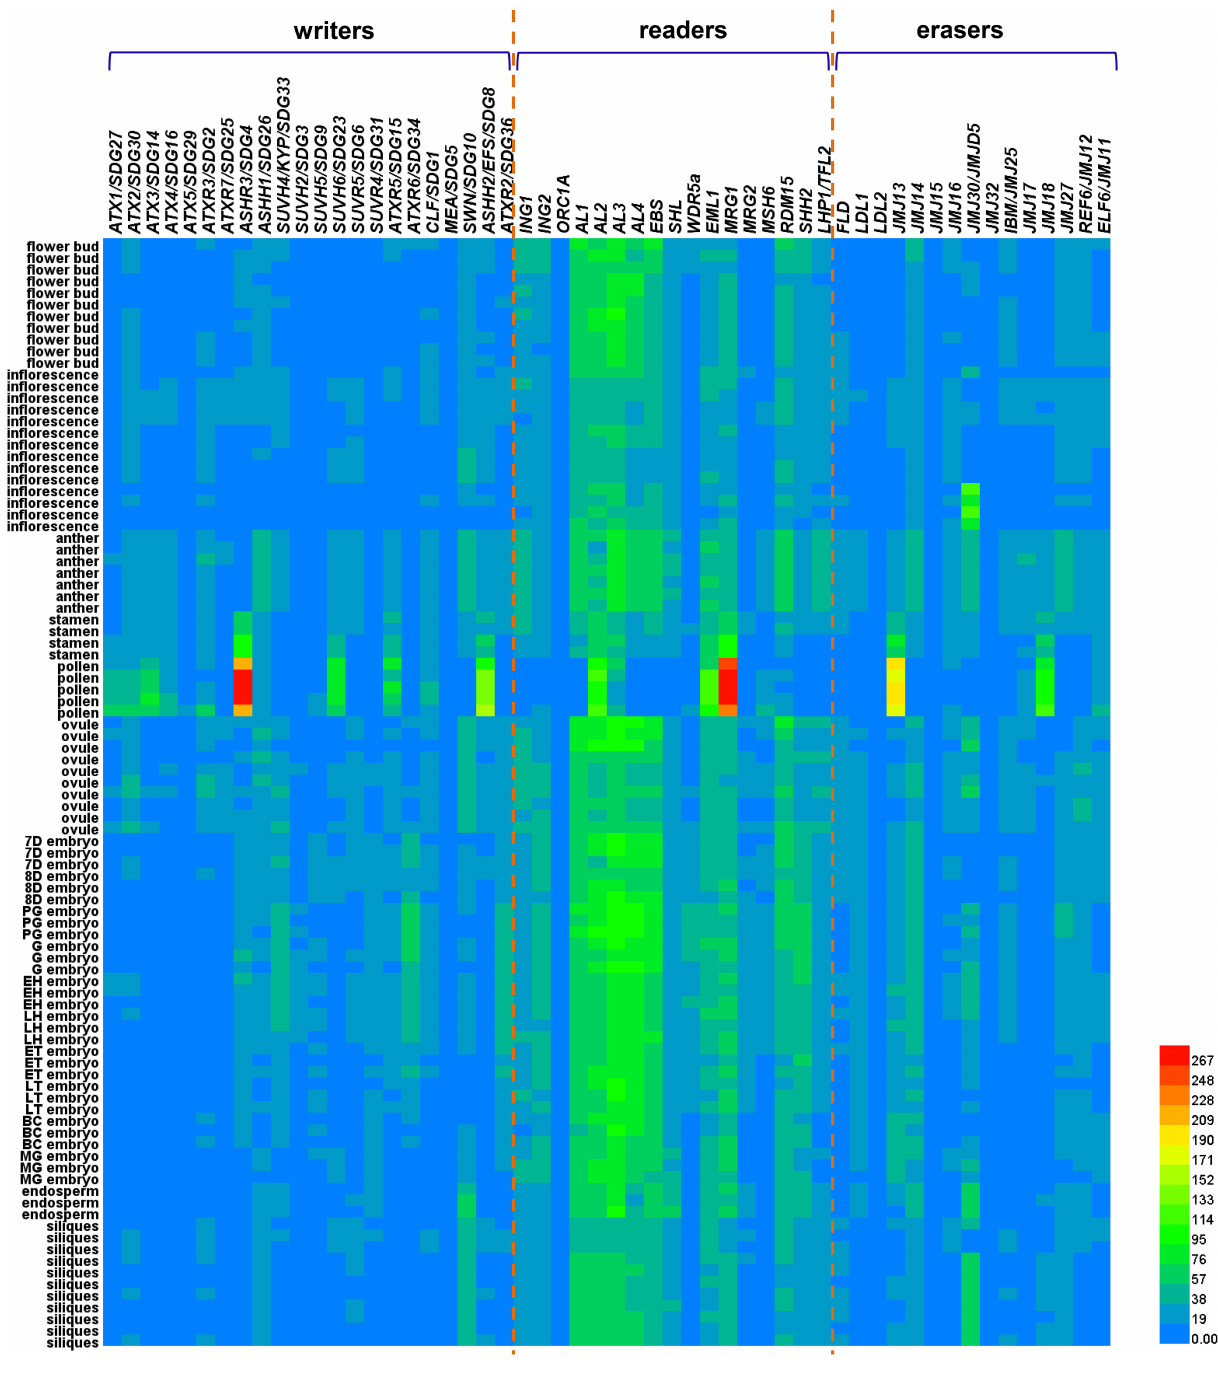
FIGURE 2 | Heat map of differential expression patterns of H3 lysine methylation associated genes across various reproductive tissues in Arabidopsis. A total of 95 RNA-seq datasets from various tissues at different stages of plant sexual reproduction, including flower buds, inflorescence, anther, stamen, pollen, ovule, embryos at different developmental stages, endosperm, and siliques were collected and thoroughly analyzed and summarize here. The heat map shows the mRNA expression profile of genes, associated with writing, reading, and erasing the H3 lysine methylation marks during plant sexual reproduction. The symbols of genes are shown at the top of the heat map, and the tissue information are listed at the left side of the heatmap. The bar at the bottom right of the heat map represents relative expression values, which was presented based on the RNA fragments per kilobase of exon model per million mapped fragments, also known as the FPKM. 7D embryo, 7-day-old embryo; 8D embryo, 8-day-old embryo; PG embryo, Preglobular embryo; G embryo, Globular embryo; EH embryo, Early heart embryo; LH embryo, Late heart embryo; ET embryo, Early torpedo embryo; LT embryo, Late torpedo embryo; BC embryo, Bent cotyledon embryo; MG embryo, Mature green embryo. The red and blue denote highly and weakly expressed genes,